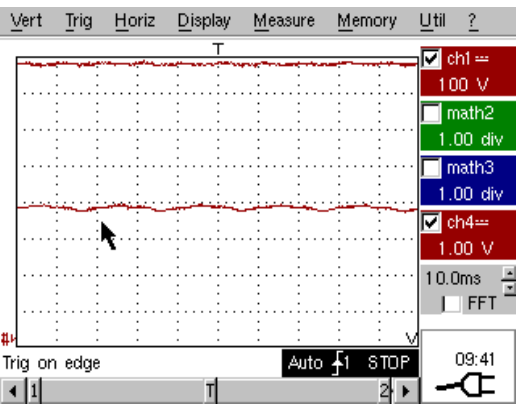
Figure 13. Oscillograms of voltages across the compensation capacitor (V+V– and V+N).